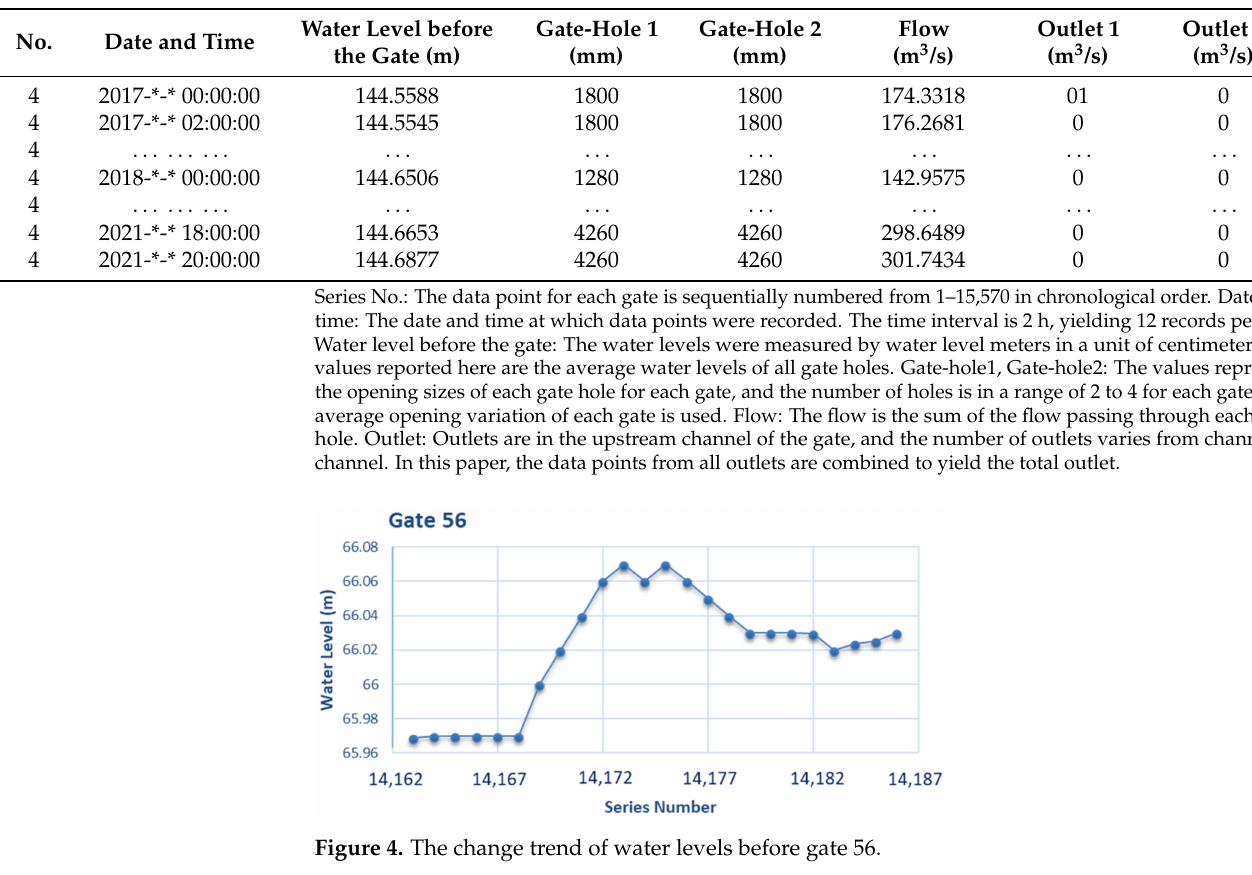
Table 5. The water level datasets before gate 56 with hydrodynamic features.